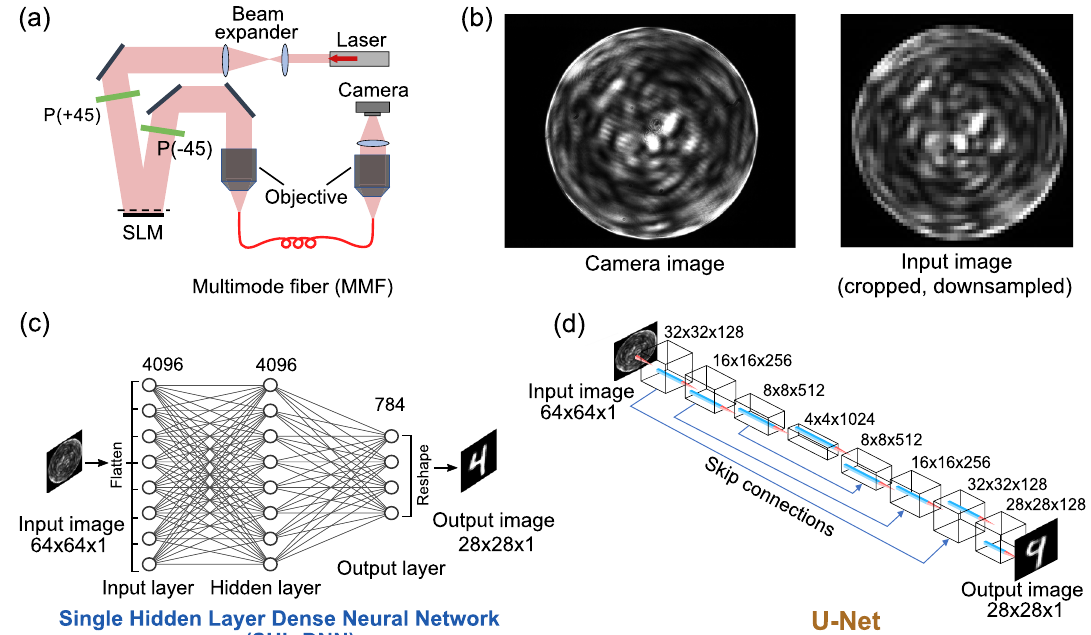
Figure 1. ( a ) Experimental setup for transmitting images through a multimode fiber. A laser beam is expanded and reflected off a spatial light modulator (SLM), which together with a pair of polarizers (P) generates an intensity modulated image. The beam is coupled into a multimode fiber (MMF), and the distal end is imaged by a camera. ( b ) Example of a scrambled image from the MMF. The ground truth image is a digit from the MNIST database (see Fig. 2). The left panel shows the full-resolution ( 1280 × 1080 pixels) camera image; the right panel shows the cropped and downsampled 64 × 64 image fed to the neural network. ( c ) Schematic of a single hidden layer dense neural network (SHL-DNN) with 4096 nodes in the hidden layer. The input image is flattened at the input layer, and the output is reshaped into a two-dimensional image. ( d ) Schematic of a U-Net consisting of contracting convolutional layers, an intermediary layer, and expanding convolutional layers. For each convolutional layer, the size a × b × c refers to a × b pixels with c filters (image depth). At the input, the 64 × 64 input image is mapped onto a 64 × 64 × 64 convolution layer (not shown) before max pooling to the 32 × 32 × 128 convolutional layer. Skip connections concatenate the outputs from successive contracting layers with the corresponding expanding layers. Batch-normalization are applied to all convolutional